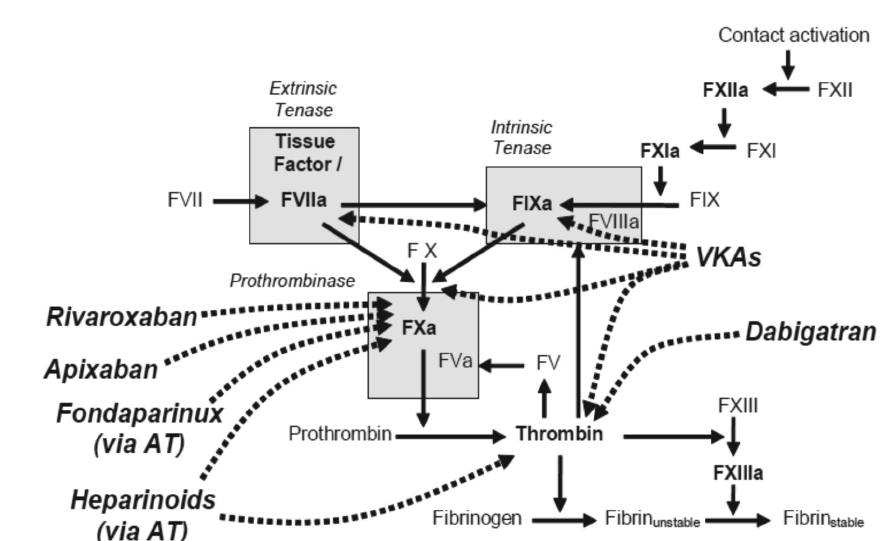
FIGURE 1 - Classic anticoagulant drugs and their targets in the coagulation cascade (Lassen, Laux, 2008). important drugs are the vitamin K antagonists